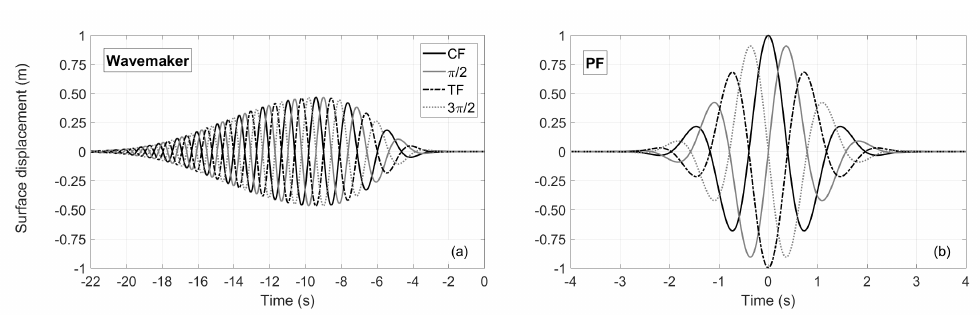
Figure 2. Timeseries of the normalized free surface elevation of four wave groups of different phases at the wavemaker ( a ) and at the PF location ( b ) calculated by linear